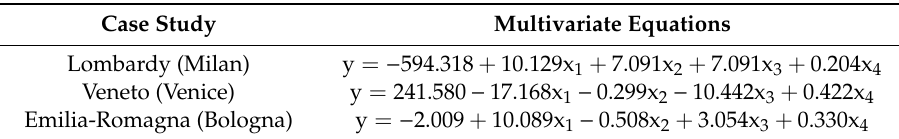
Table 8. The provided equations in three case